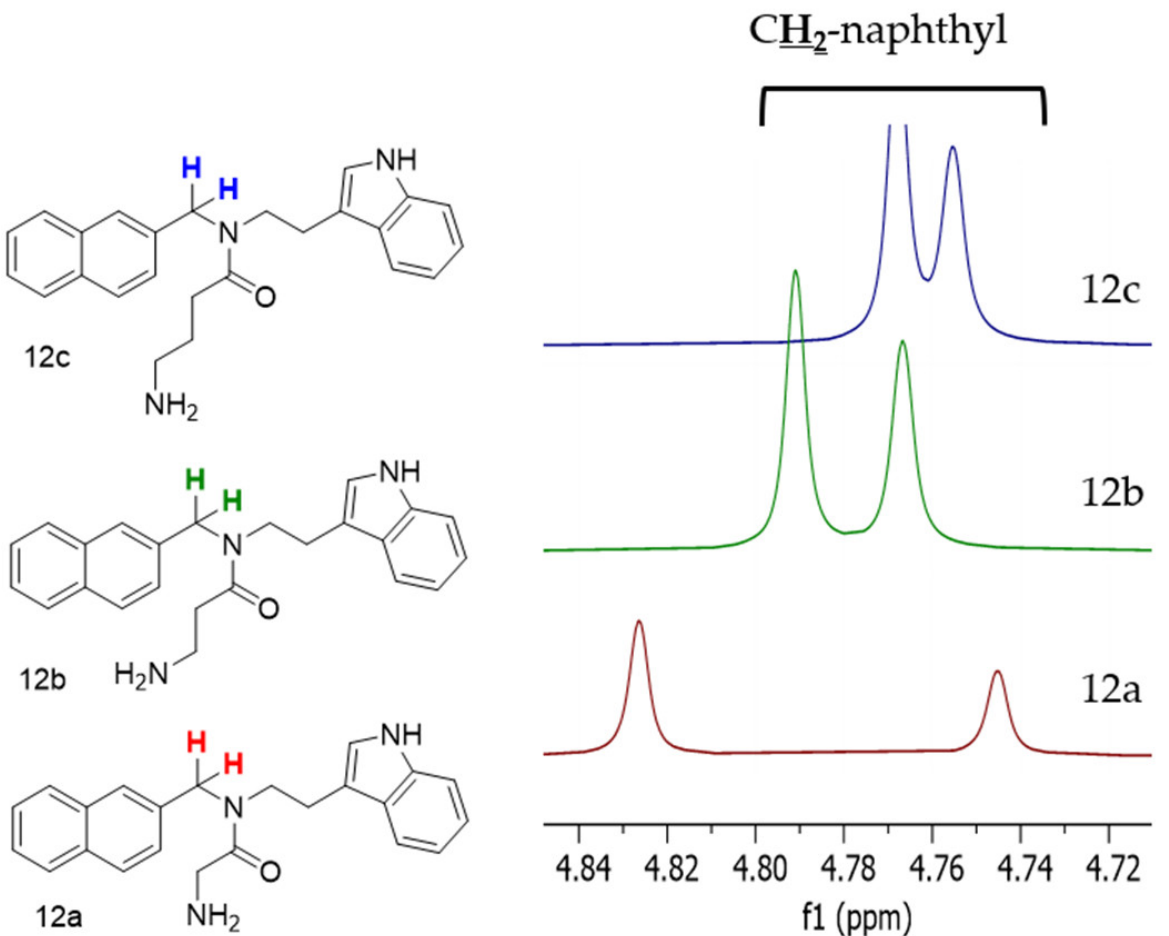
Figure 5. Expanded 1 HNMR spectra of the major (M) and the minor (m) isomers for compound 12a over 298–502 K in DMSO-d 6 , CH 2 -naphthyl region on right and NH-indole on left. (*) the coalescence temperature.